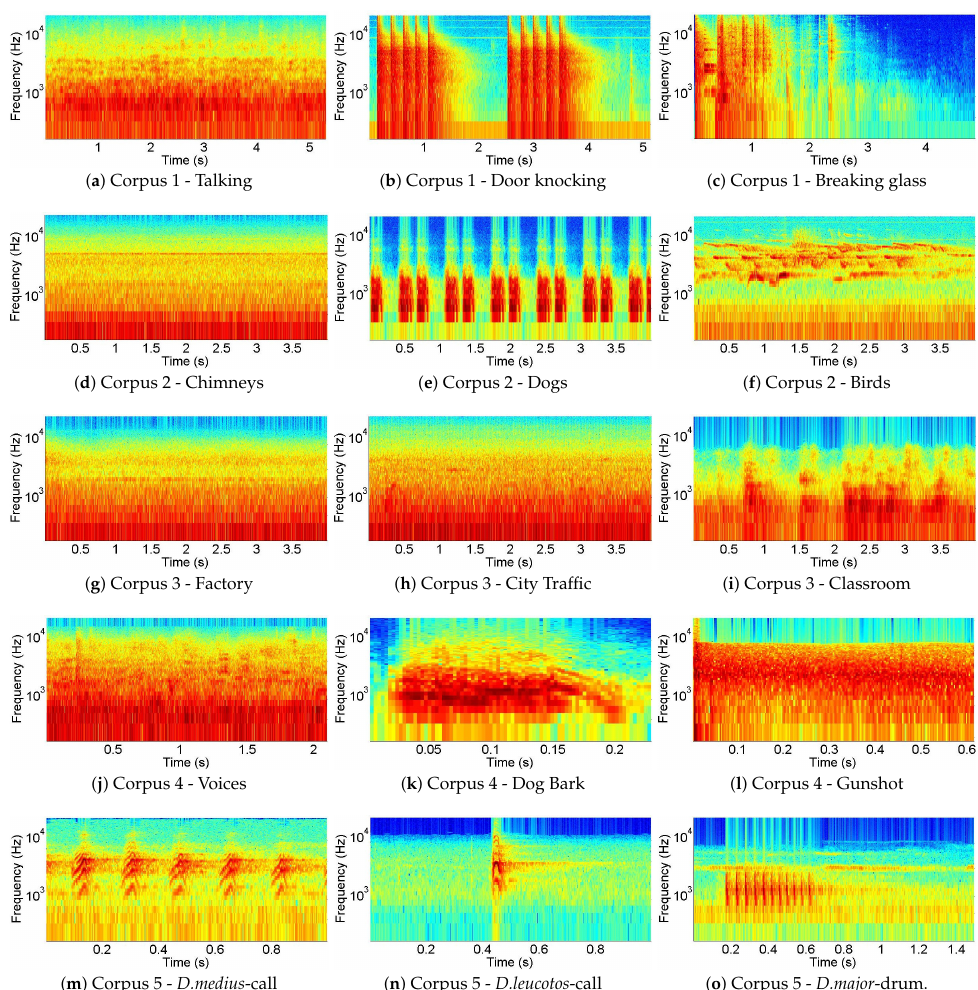
Figure 1. Selection of representative spectrograms of some of the classes in the corpora . The temporal window varies between approximately 0.2 and 5 s, but the vertical axis (Hz) is